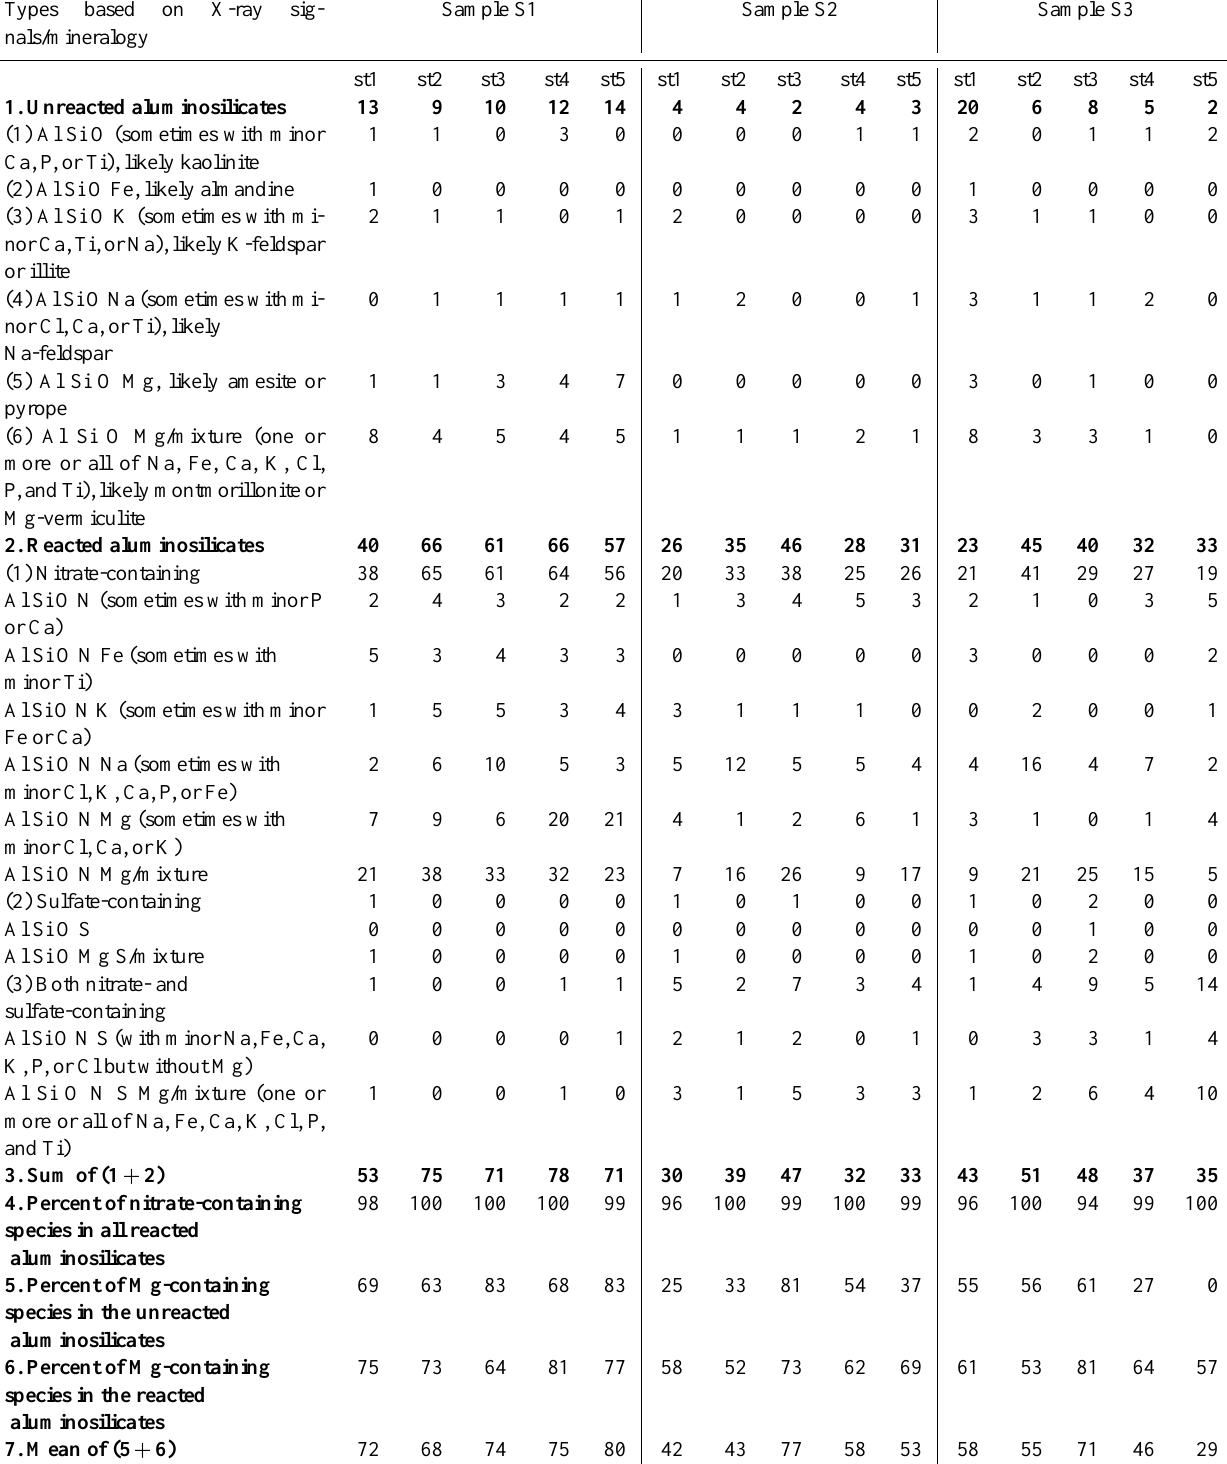
Table 5. Relative number abundances (%) of various types of aluminosilicates in samples S1–S3. Types based on X-ray